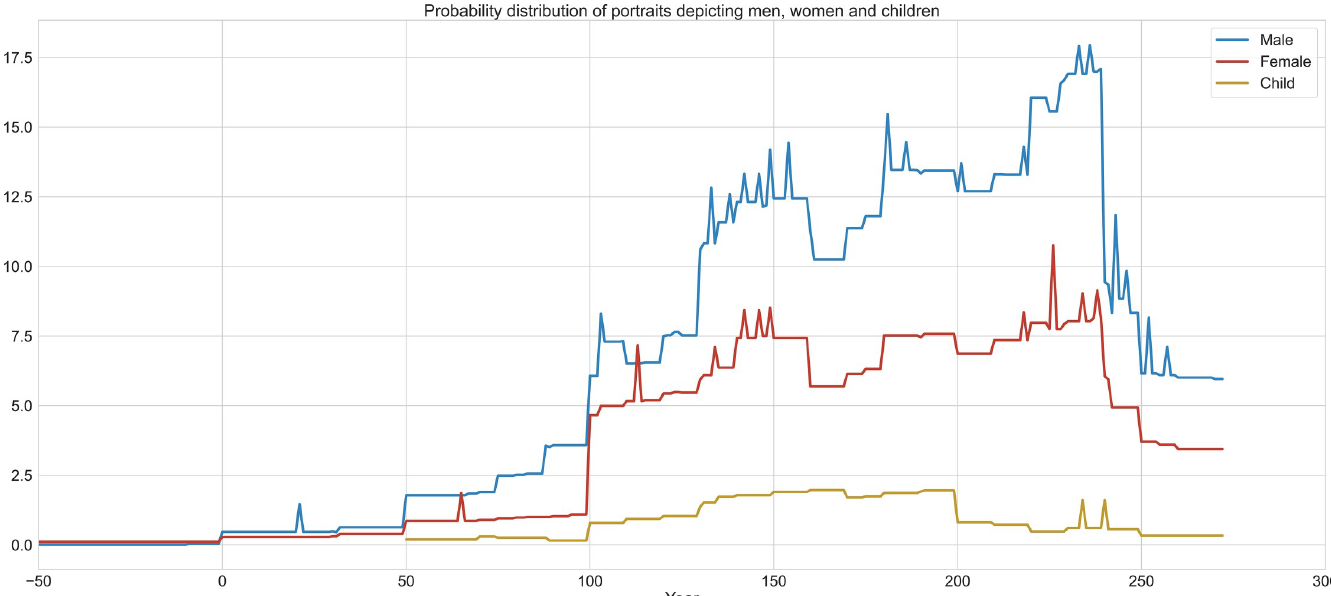
Fig 8. Probability distribution of dates for three types of funerary objects (portraits, tombs, bones from graves). Graph © authors.